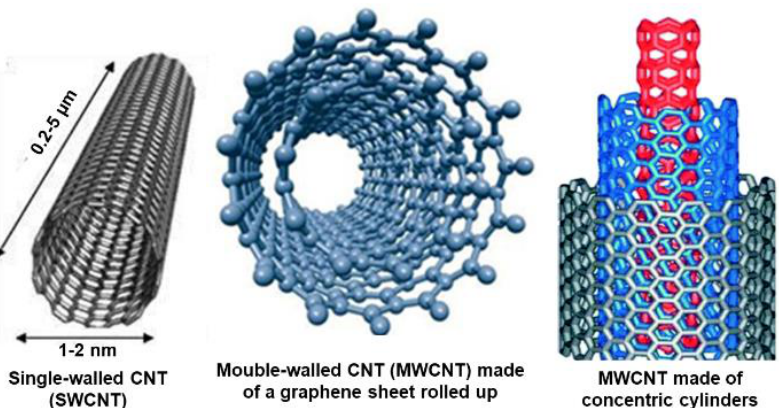
Figure 7. From the left: structures of a SWCNT, of a MWCNT made of a single graphene sheet rolled up and of a MWCNT made of more than two graphene cylinders one inside the other. These images by unknown author are licensed under CC BY.